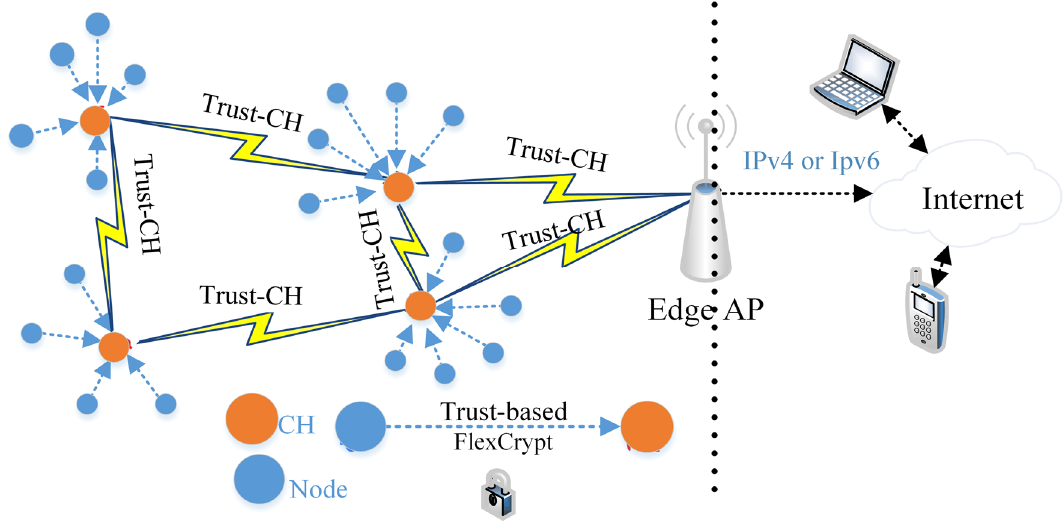
Figure 2. The Trust-CH framework.